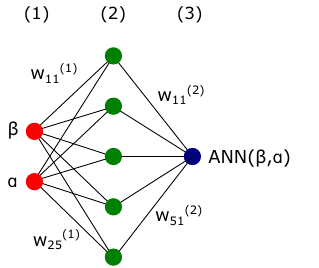
Fig. 4 Scheme of an exemplary artificial neural network used to rep- resent the profile function in the double distribution